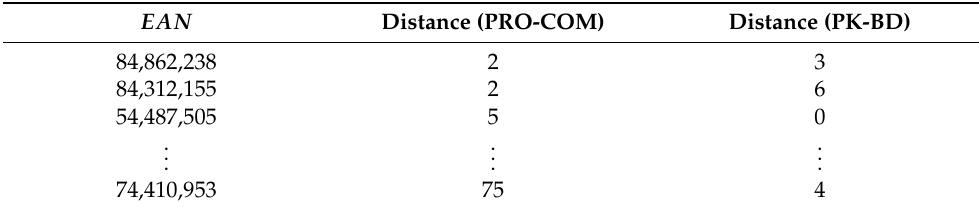
Table 9. PK-BD approach: Example of a matrix with distance vectors as columns after sorting the